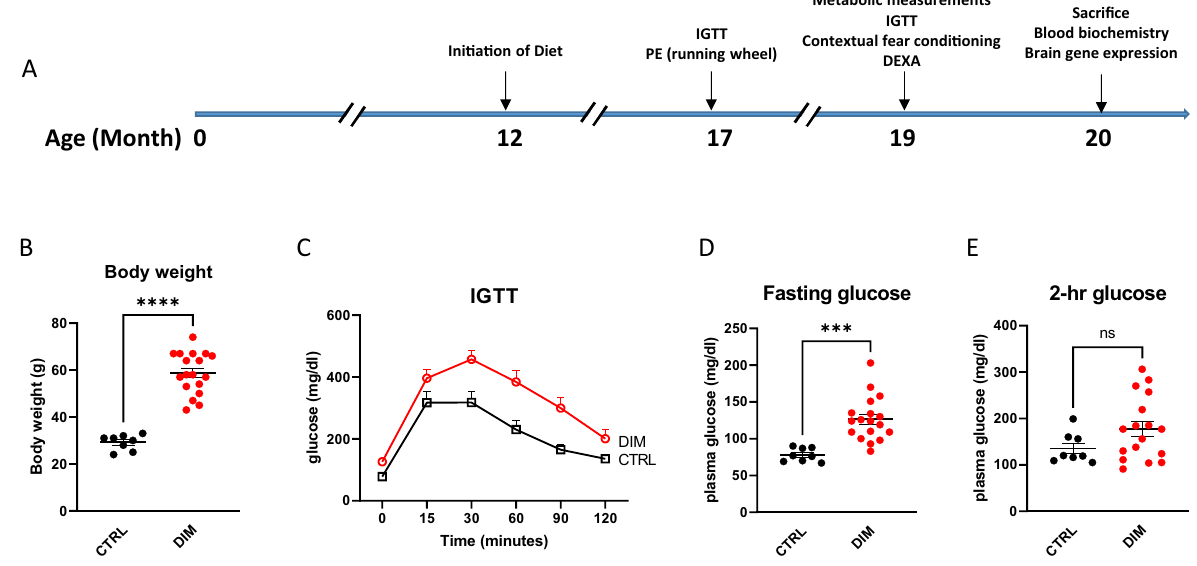
Figure 1. Scheme of the experimental design and the effect of high fat diet in middle-aged female mice ( A ) Scheme of the experimental design. ( B – E ) Five-month high fat diet on body weight and glucose utilization as reflected by ( C ) IGTT, ( D ) fasting glucose and ( E ) post prandial glucose in plasma. Data represents mean ± SEM, n = 8–18 per